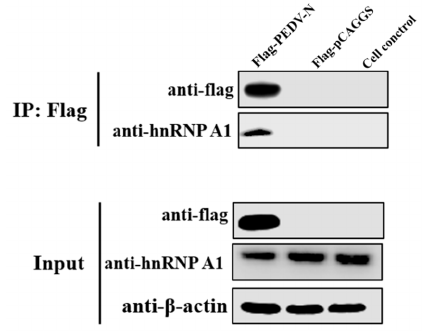
Figure 3. Interaction of hnRNP A1 and PEDV N protein. HEK293T cells were transfected with a vector expressing PEDV N protein with a flag tag (flag-PEDV-N) or empty vectors (flag-pCAGGS) and the whole-cell lysates obtained at 24 hpt were immunoprecipitated with anti-Flag mAb. After separation by SDS-PAGE, proteins were detected by immunoblotting with the indicated antibodies (IP: Flag). Cell lysates were also applied to confirm the expression of proteins